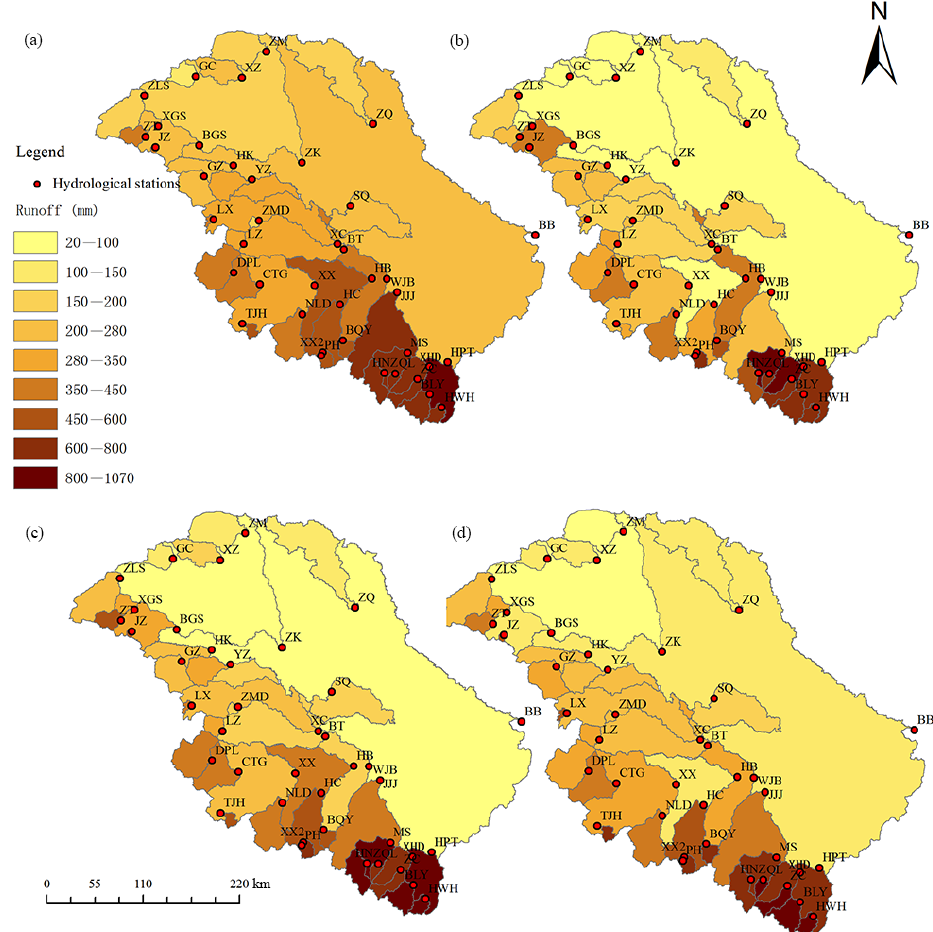
Figure 7. Spatial distribution of the mean annual runoff estimated from (a) the Budyko method, (b) hydro-stochastic interpolation, (c) our coupled method, and (d) the